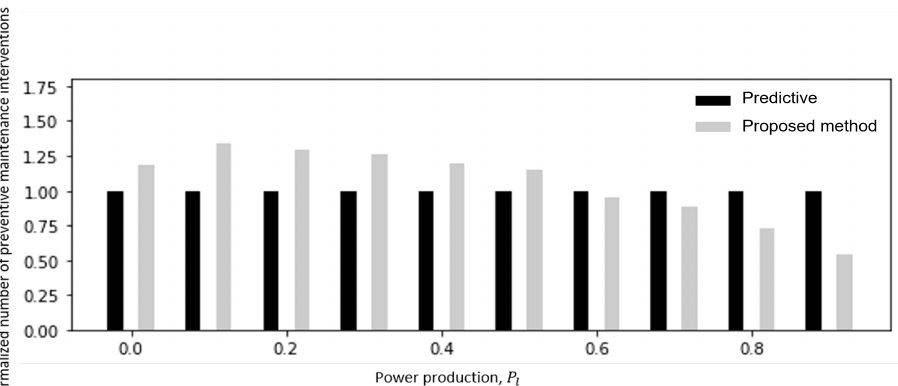
Figure 5. Number of maintenance interventions at different power production values, with C =